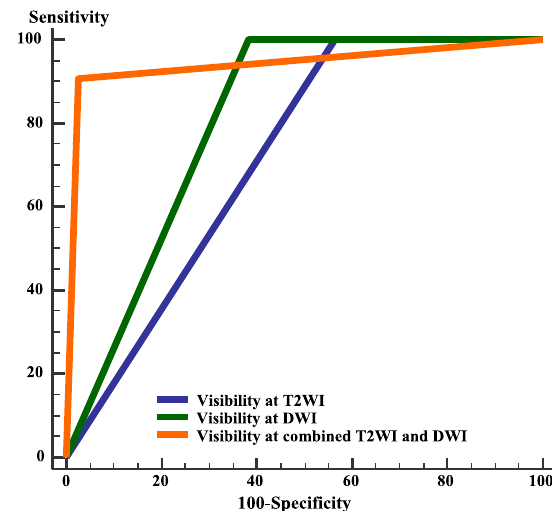
Fig. 2 Accuracy of the MRI technique for predicting abscesses among the studied